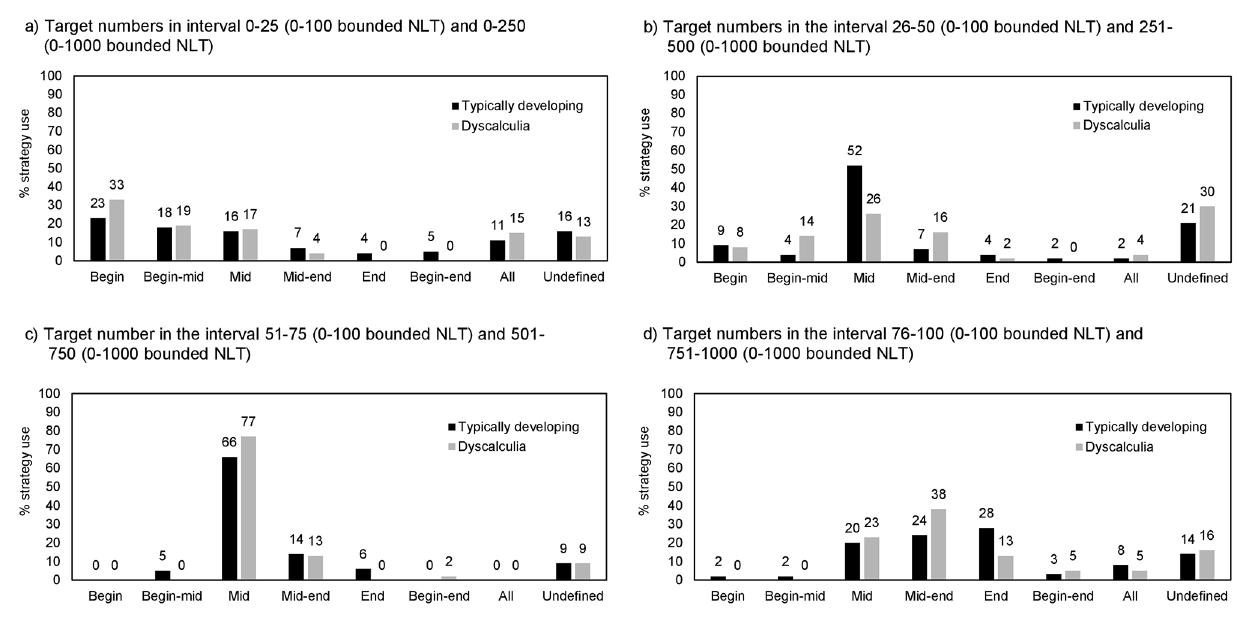
Figure 5. Percentages of trials in which each proportion based strategy was used, seperated per target number interval. In-Depth Analysis of Strategy Use in the Bounded